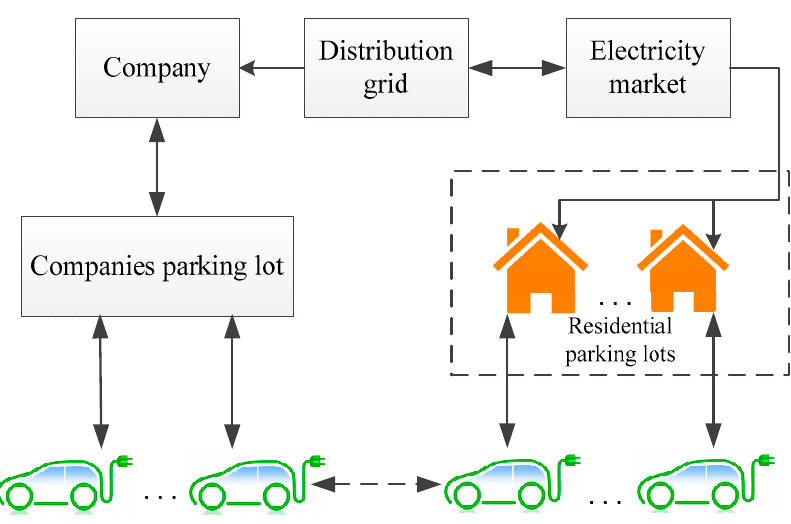
Figure 1. The diagram of the situation under consideration.